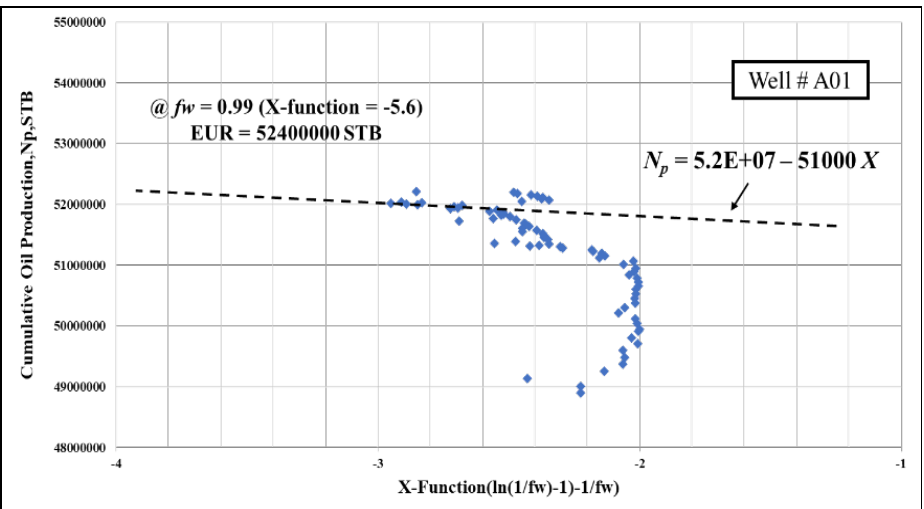
Figure 21. X-plot for well